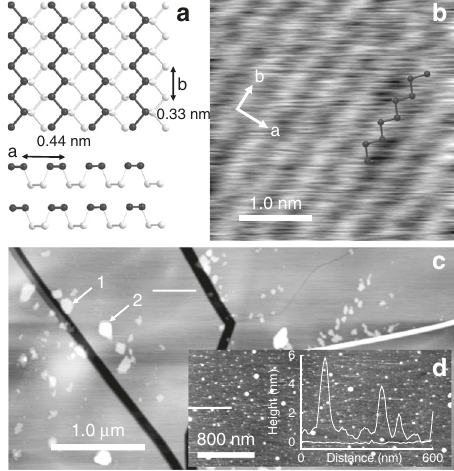
Fig. 1 Overview of the black phosphorus surface. a Schematic showing the surface structure of black phosphorus. b Tapping mode AFM showing the surface lattice structure with an overlay representing the surface phosphorus atoms. c Large-scale AFM image showing structural features on the freshly cleaved surface of a single crystal of BP. Islands marked 1 and 2 have heights of 3.35 ± 0.1 nm and 9.6 ± 0.1 nm, respectively. Both images were acquired with a NuNano probe with a second harmonic of 2.385 MHz. d AFM scan of the same sample of BP taken 2 days later. An inset shows two surface pro fi les taken along the white lines in Fig. 1c, d which highlight the enhanced roughness after prolonged exposure to the atmosphere due to oxidation. This image was acquired with a Multi75Al-G probe using the fundamental resonance of 69.46